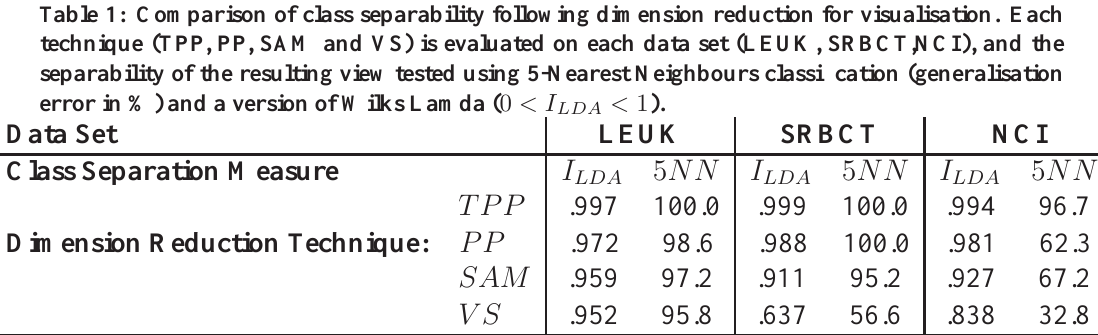
Table 1: Comparison of class separability following dimension reduction for visualisation. Each technique (TPP, PP, SAM and VS) is evaluated on each data set (LEUK, SRBCT,NCI), and the separability of the resulting view tested using 5-Nearest Neighbours classification (generalisation error in %) and a version of Wilks Lamda ( 0 < I LDA < 1